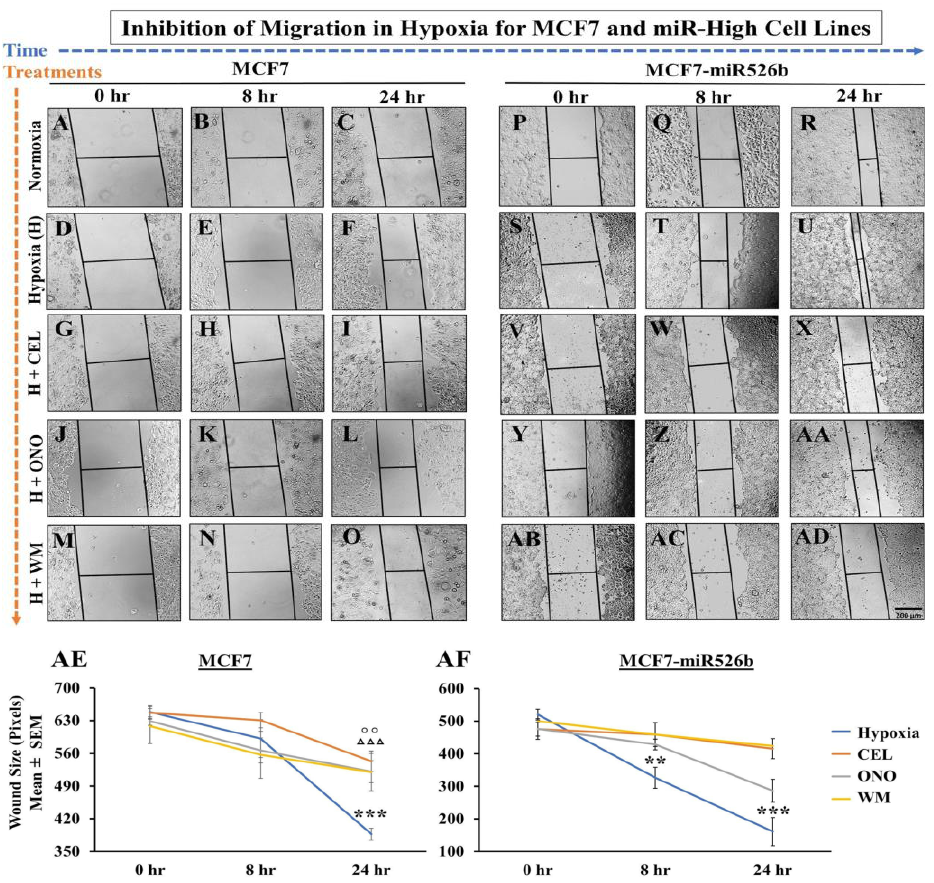
Figure 9. Inhibition of cell migration: Migration of cells recorded at 0, 8 and 24 h. ( A – C ) Representative images of MCF7 cells in normoxia, ( D – F ) in hypoxia, ( G – I ) hypoxia with CEL, ( J – L ) hypoxia with ONO and ( M – O ) hypoxia with WM. ( P – R ) Representative images for MCF7-miR526b in normoxia, ( S – U ) in hypoxia, ( V – X ) hypoxia with CEL, ( Y – AA ) hypoxia with ONO, and ( AB – AD ) hypoxia with WM. ( AE ) Quantitative data for the inhibition of MCF7 cell migration with inhibitors. ( AF ) Quantitative data of inhibition of hypoxia-enhanced migration of MCF7-miR526b. Data are presented as the mean ± SEM of quadruplicate biological replicates; ** p < 0.01 and *** p < 0.001. * = Hypoxia, ◦ = Celecoxib, ▵ = ONO-AE3-208.